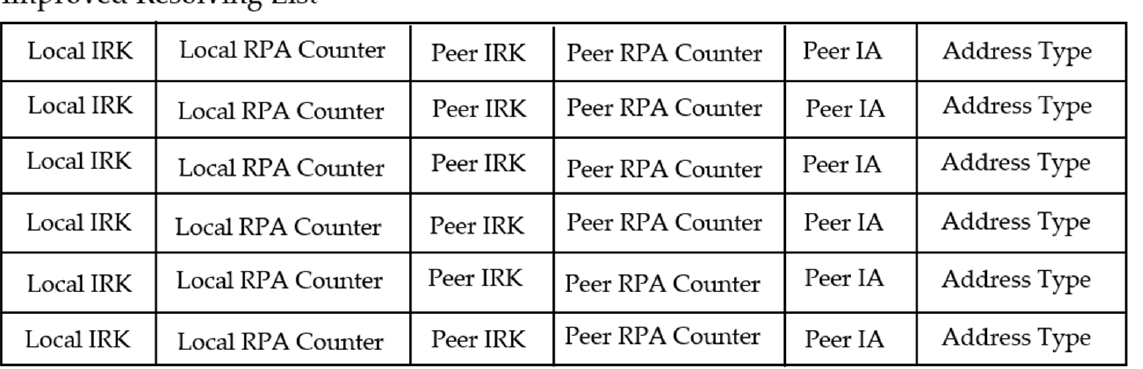
Figure 9. Logical structure of improved resolving list.